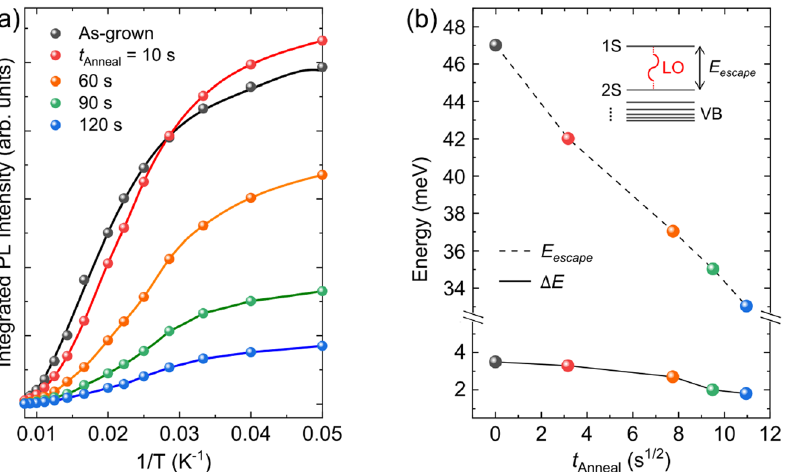
Figure4: (a)IntegratedPLintensitywithrespecttothemeasurementtemperaturefora seriesof QDsamples,alongwiththemodelfitprofiles (solidlines).(b)Thermalescapeenergy E escape andthermalactivationenergy Δ E fortheasgrownandtheintermixedQDsamplesderivedfrom Figure 4a. E escape in the valence band (VB) is described in the inset. QD, quantum dot; PL, photoluminescence.